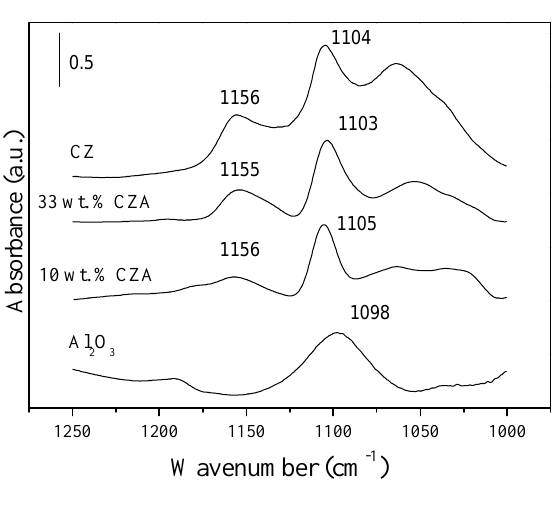
Fig. 4 TPR-MS traces of H O (M/z 18) of a 2 10 wt. % CZA support aged at different